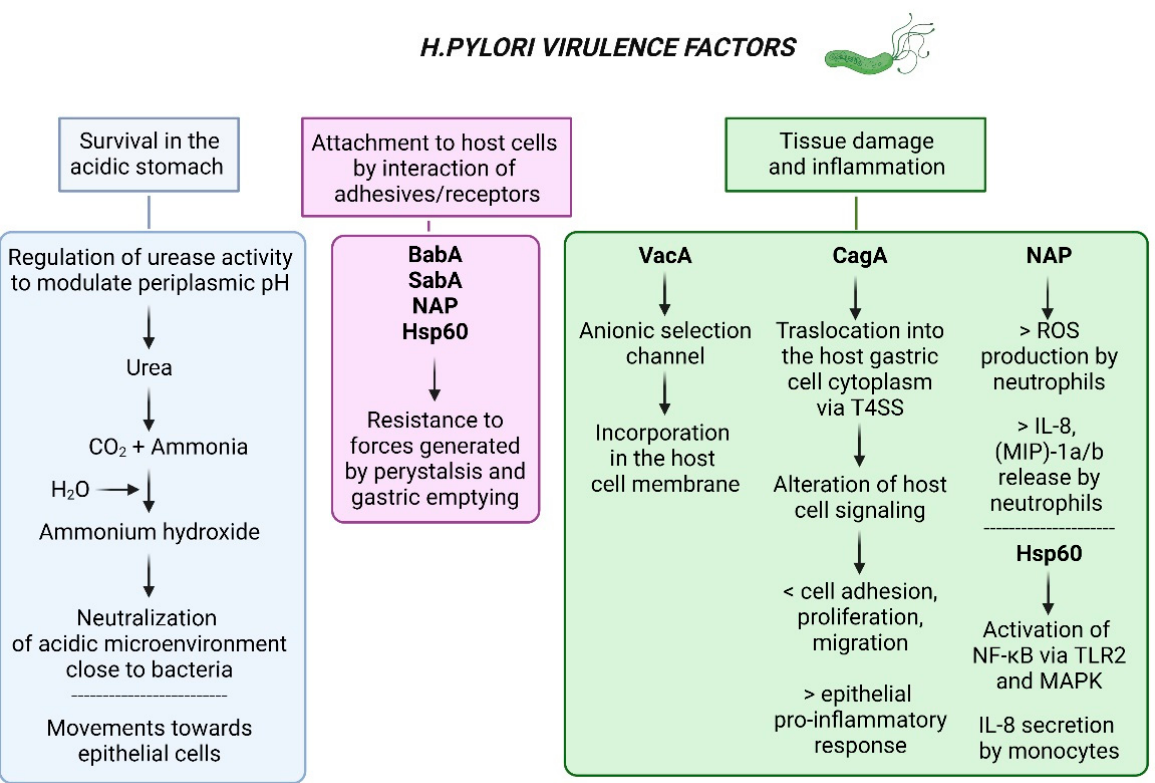
Figure 2. Virulence factors involved in the pathogenicity of H. pylori . Abbreviations : BabA: blood group antigen-binding adhesion A; SabA: sialic acid-binding adhesion A; NAP: neutrophil activating protein; Hsp: heat shock protein; VacA: vacuolating cytotoxin gene A; CagA: cytotoxin-associated gene A; T4SS: type IV secretion system; NAP: neutrophil-activating protein; ROS: reactive oxygen species; IL: interleukin; MIP: macrophage inflammatory protein; NF-kB: nuclear factor kappa-light-chain-enhancer of activated B cells; TLR: toll-like receptor; MAPK: mitogen-activated protein kinase. Created with Biorender.com.